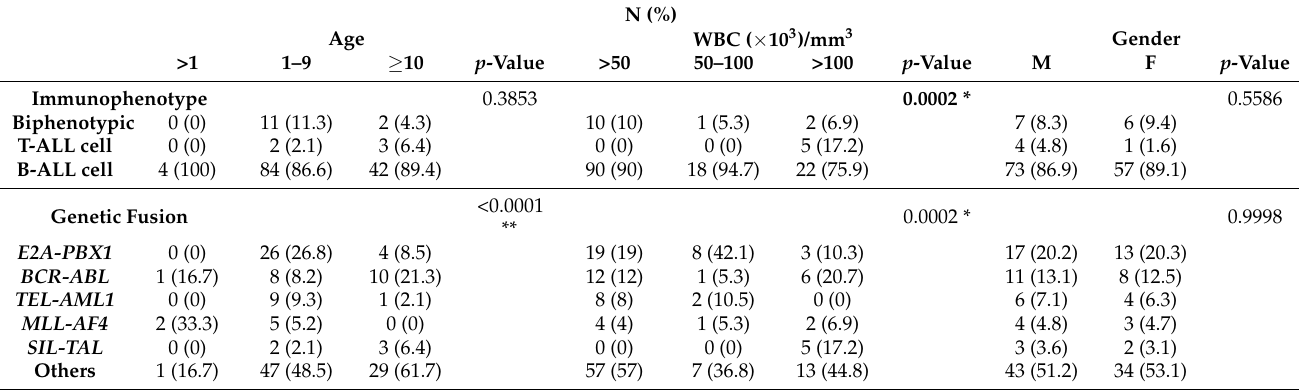
Table 1. Clinical features analysis of acute lymphoblastic leukemia patients.